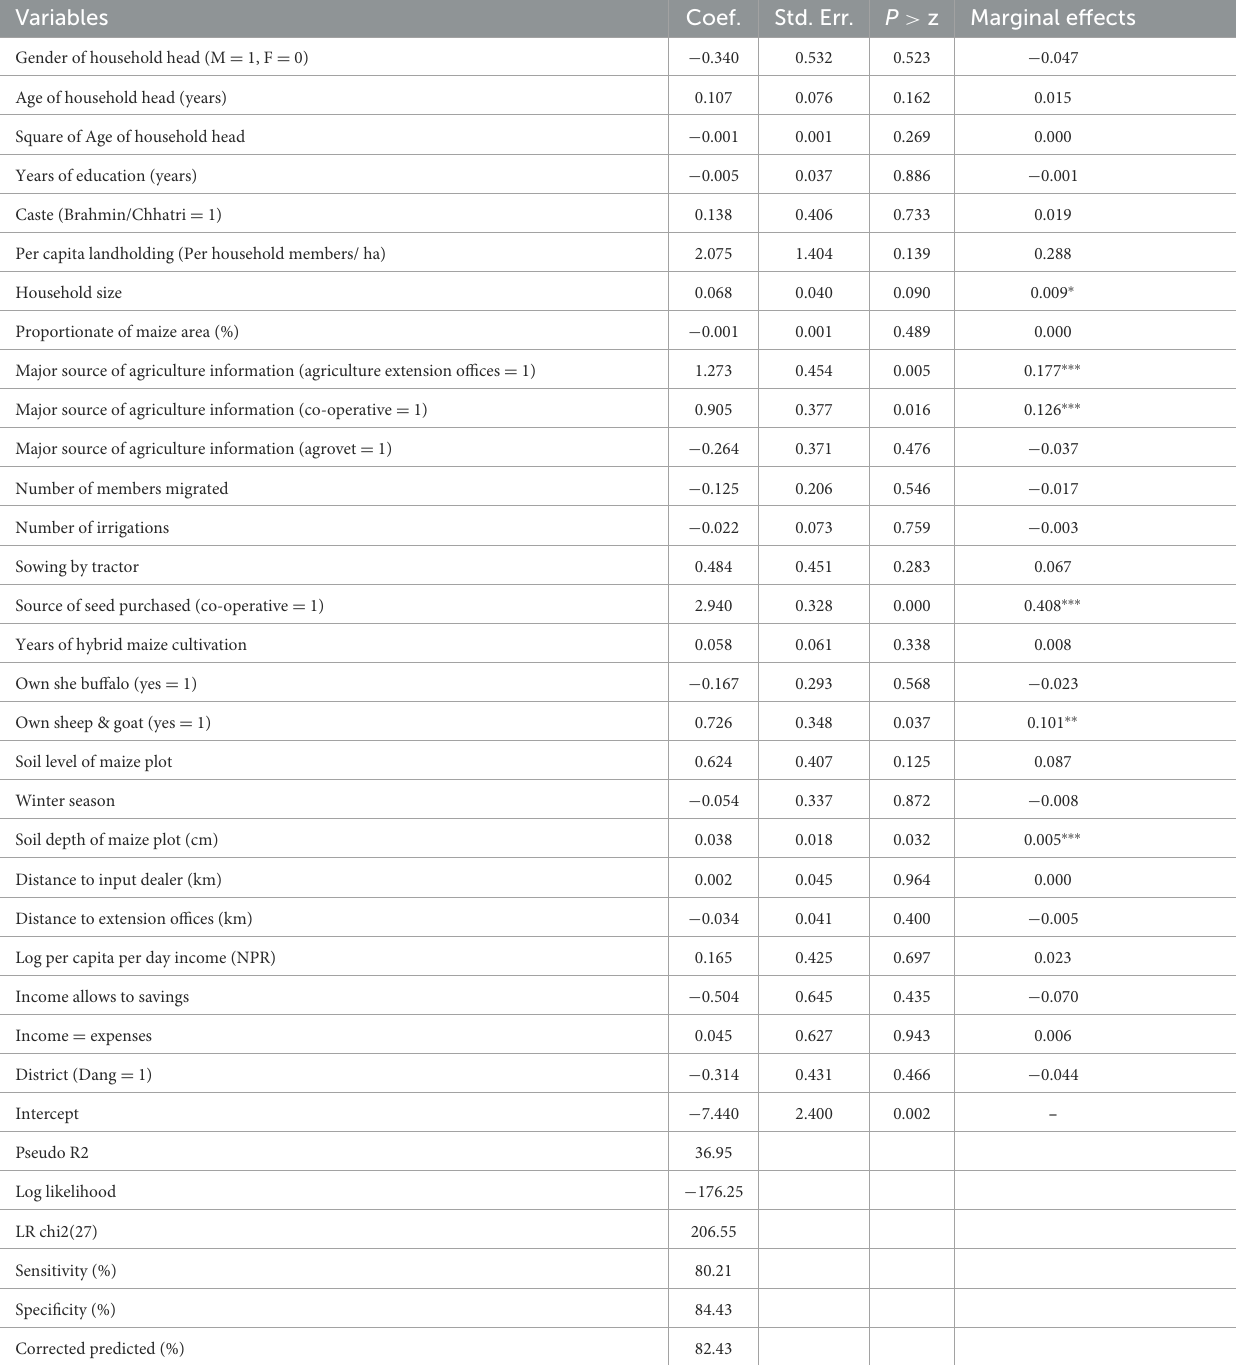
TABLE 6 Logit estimation of adoption of heat-tolerant maize hybrids in the Terai region of Nepal. Variables Coef. Std. Err. P > z Marginal